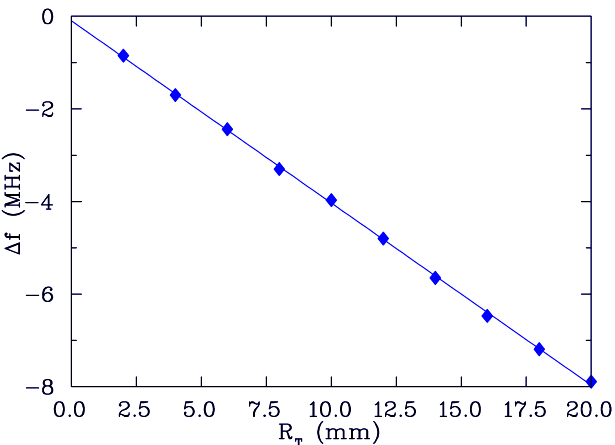
FIG. 22. (Color) Simulated frequency shift as a function of the at a constant tuner height of h (cid:1) 30 mm . tuner radius R T